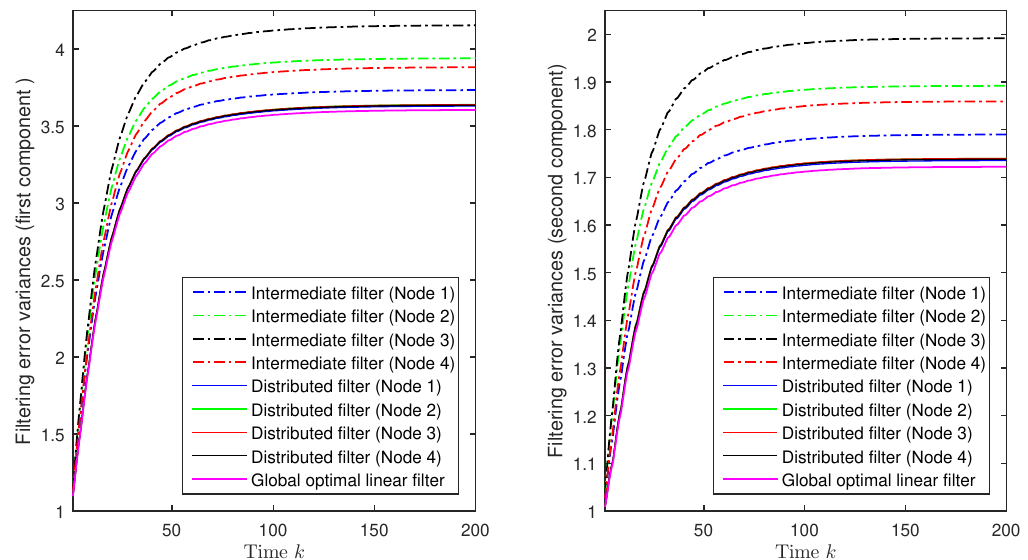
Figure 2. Filtering error variance comparison of intermediate, distributed, and global optimal linear